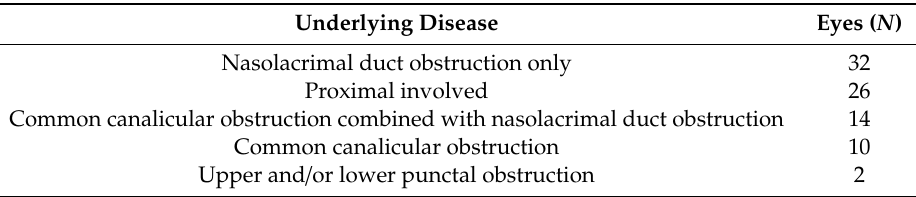
Table 1. Type of obstruction as determined using